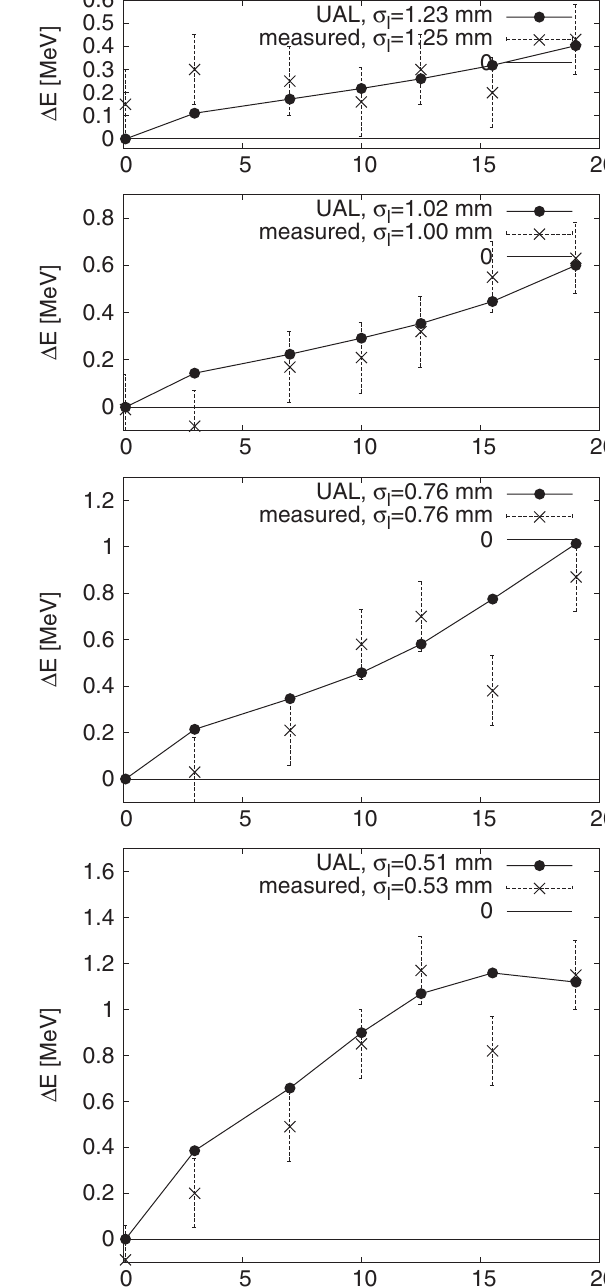
FIG. 9. Energy loss measurements by Braun et al. [5] as in the shielding chicane, for bunch charge Q ¼ functions of R 56 15 nC and various values of rms bunch length (cid:5) l . There are no adjustable parameters for the UAL simulations in these plots.